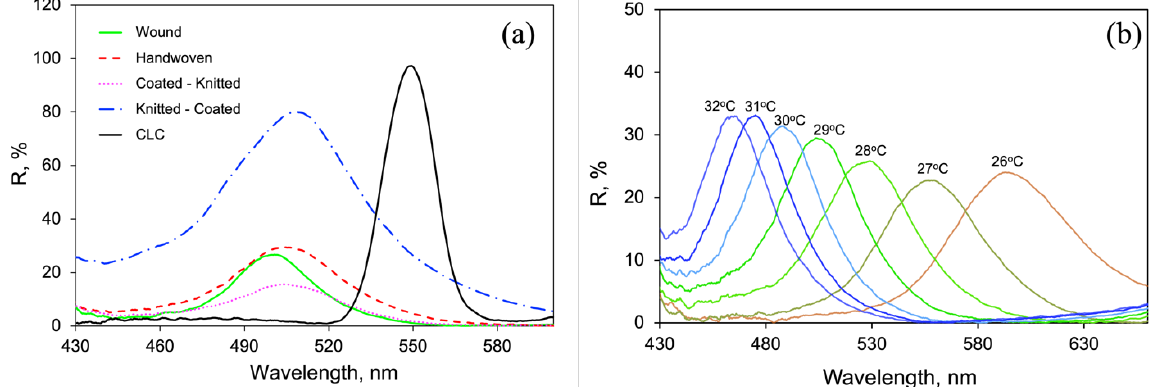
Figure 5. Reflectance of SFXC coated yarn and fabric. ( a ) Comparison of the reflectance of the yarn and fabric swatch with a regular cholesteric liquid crystal (CLC) sandwiched between two cover slips (black solid line), wound coated fibers around glass plate (green solid line), handwoven (red dashed line), knitted after coating process (magenta dotted line) and coated after knitting bare yarn (blue dash-dotted line). ( b ) Reflectance spectra showing the shift of λ max with temperature.